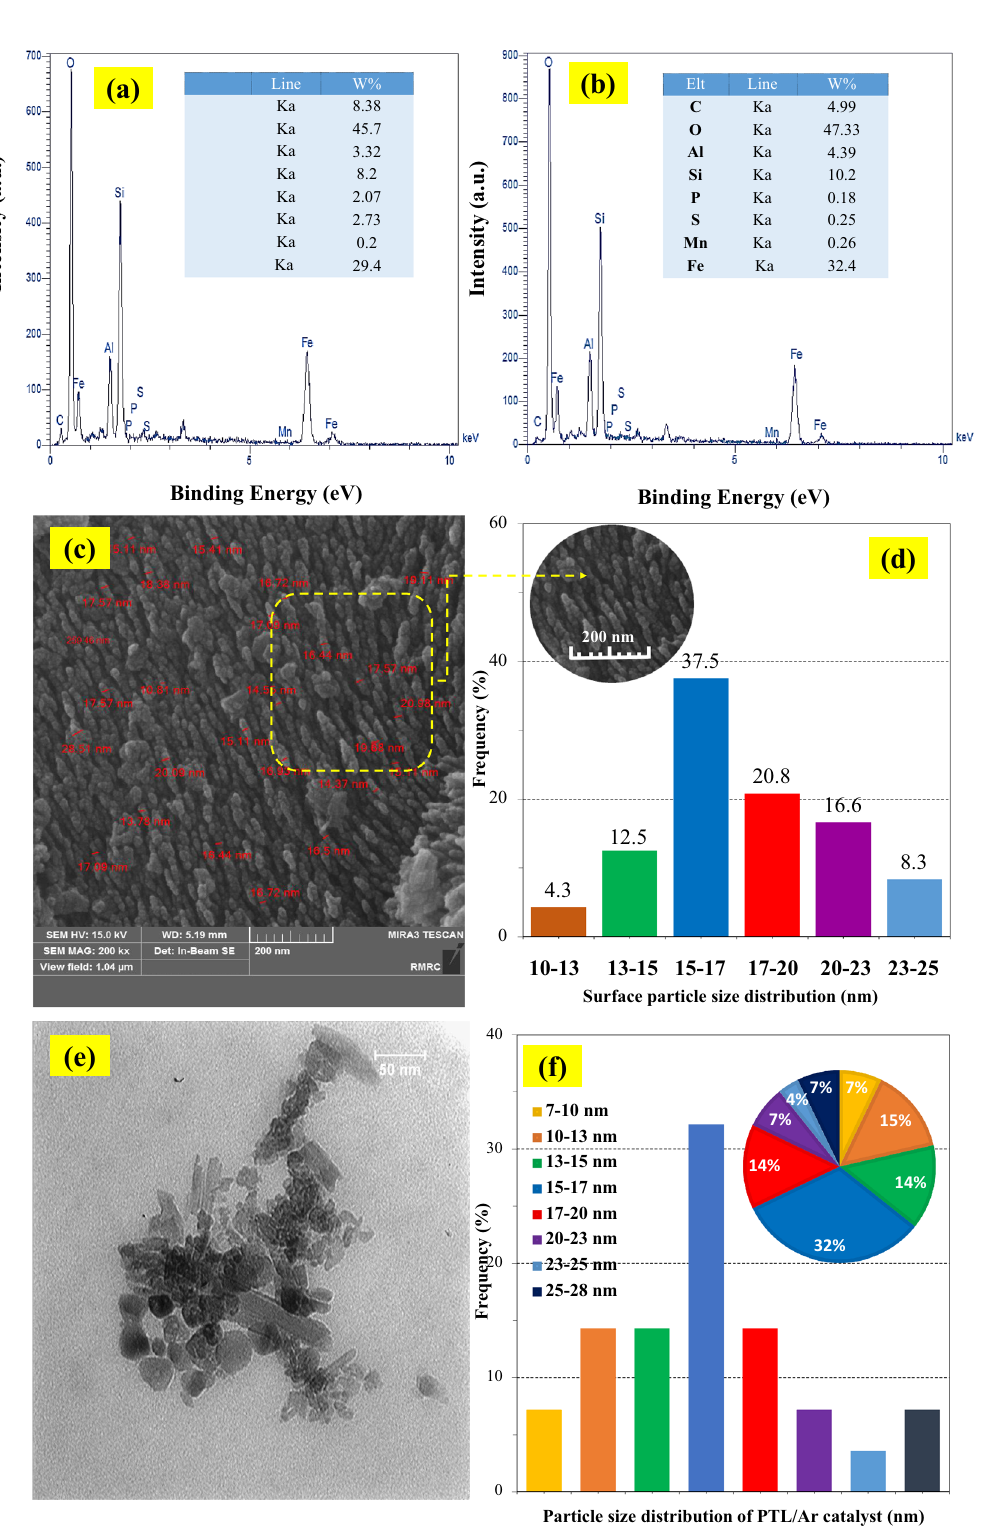
Figure 5. EDX and elemental analysis of ( a ) NL and ( b ) PTL/Ar; particle size distribution of PTL/Ar according FESEM ( c , d ) and TEM ( e , f )